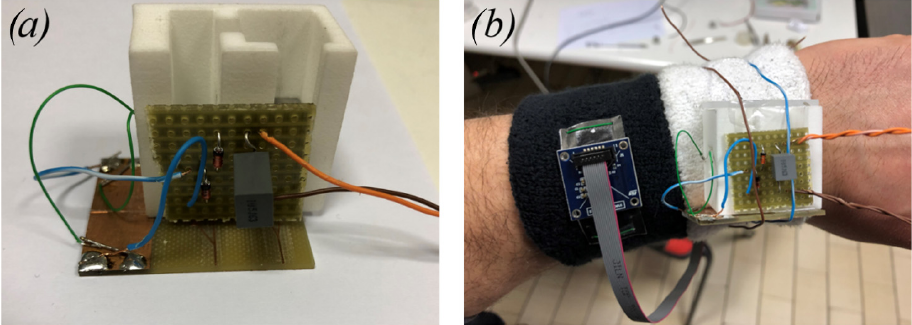
Figure 7. ( a ) Close-up of the rectifier circuit board. ( b ) Accelerometer and prototype tied to the wrist.